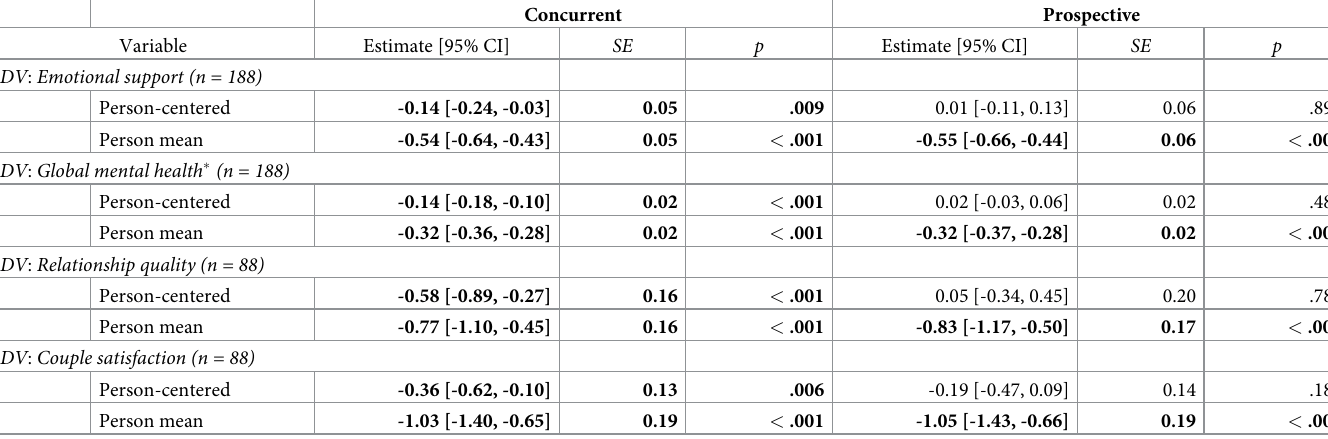
Table 3. Results from concurrent and prospective